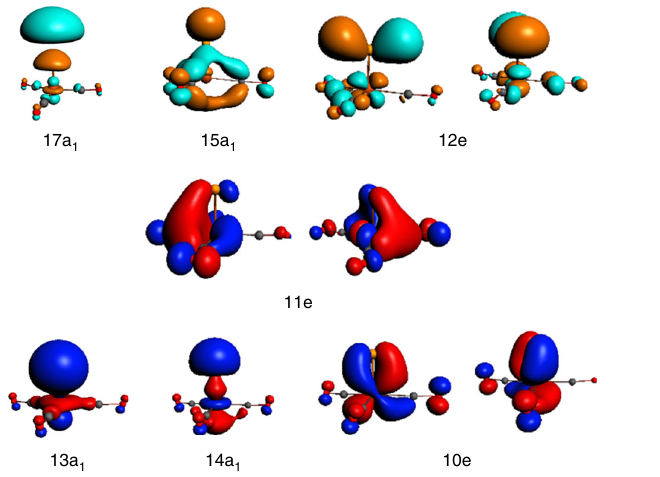
Fig. 3 The canonical Kohn-Sham valence molecular orbitals of BFe(CO) 3 − . The B – Fe nonbonding (11e), bonding (13a 1 , 10e, 14a 1 ) and the corresponding antibonding molecular orbitals (17a 1 , 12e, 15a 1 ) are plotted with isosurfaces = 0.05 au